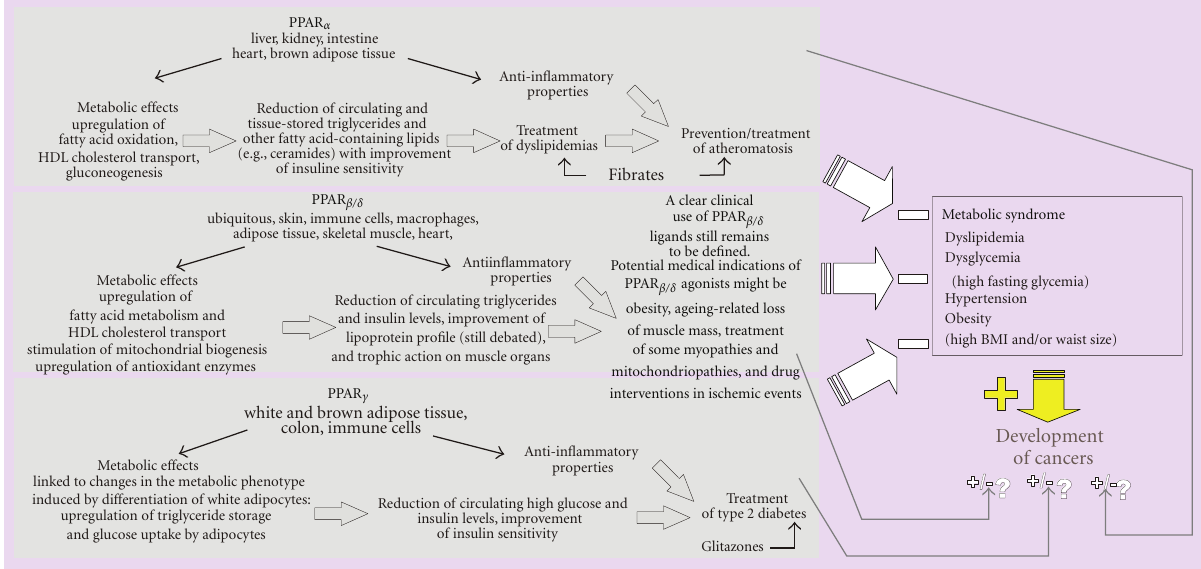
Figure 8: PPARs, metabolic syndrome and cancer. This figure illustrates that (i) PPAR activation may counteract the development of meta- bolic syndrome, (ii) metabolic syndrome increases the risk for cancer, and (iii) PPARs and their ligands exhibit pro-and antitumoral proper- ties towards cancer progression. Metabolic syndrome is considered as a procancer target antagonised by PPARs, a feature (not further discuss- ed in the text) giving support to the view of a possible preventive anticancer action of PPAR ligands which may be supplied by the diets (polyunsaturated fatty acids, for instance). The figure also compares the links leading to the current medical and pharmacological applica- tions of PPAR